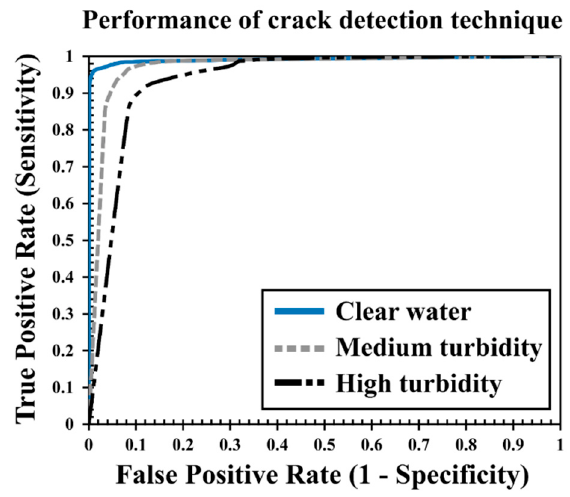
Figure 15. Receiver operating characteristic (ROC) curves for the crack detection technique applied under three turbidity conditions.